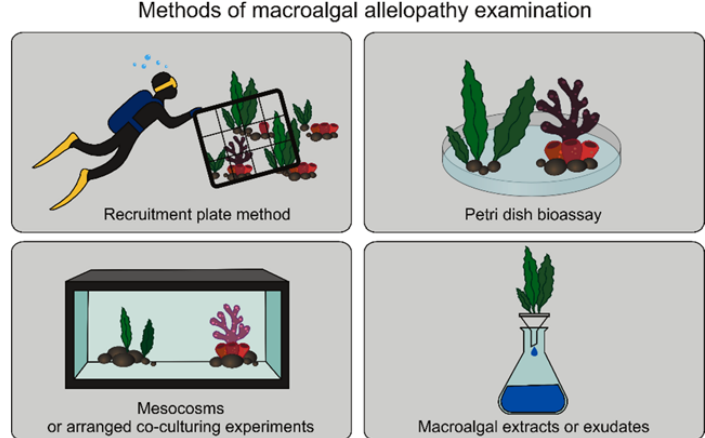
Figure 3. Most used methods to investigate the allelopathy